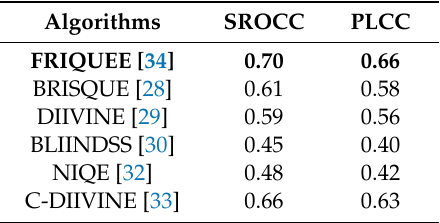
Table 2. Performance of some algorithms on the LIVE CHALLENGE DATABASE. Algorithms SROCC